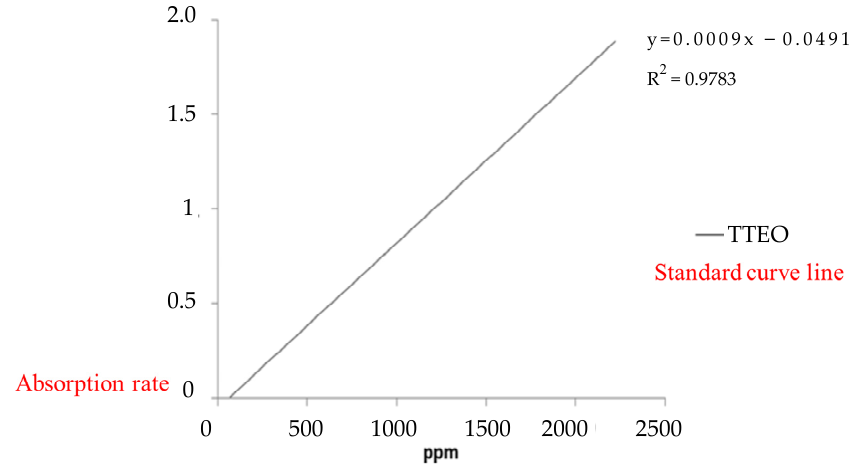
Figure 6. The UV-visible spectrum of tea tree essential oil.